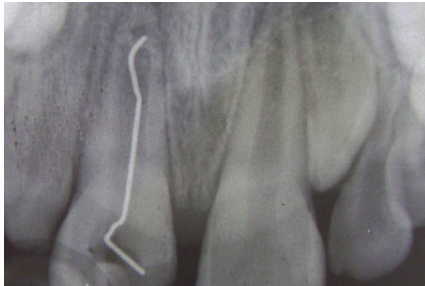
Figure 1: Intraoral periapical radiograph showing the radiopaque foreign body.